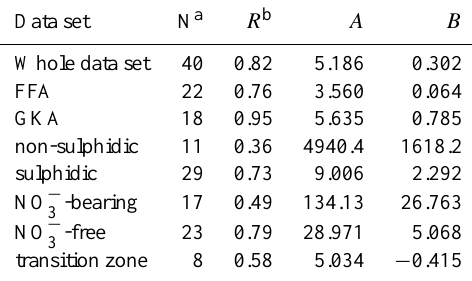
Table 6. Simple regression between D cum (365) and